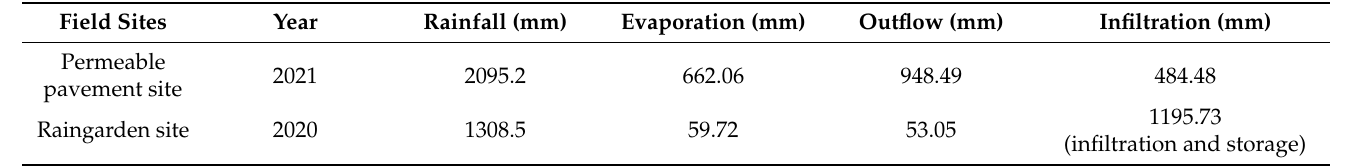
Table 4. Simulation results of the annual water performance at the two field